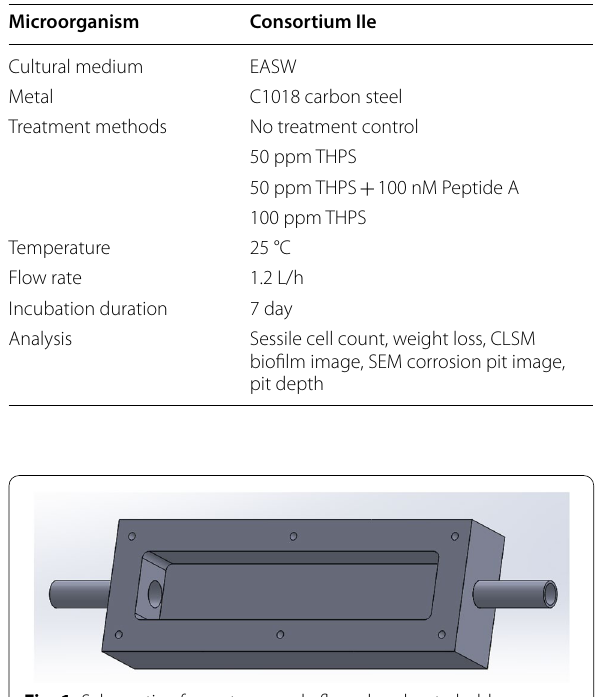
2.5 cm W 1.8 cm D ) × ×